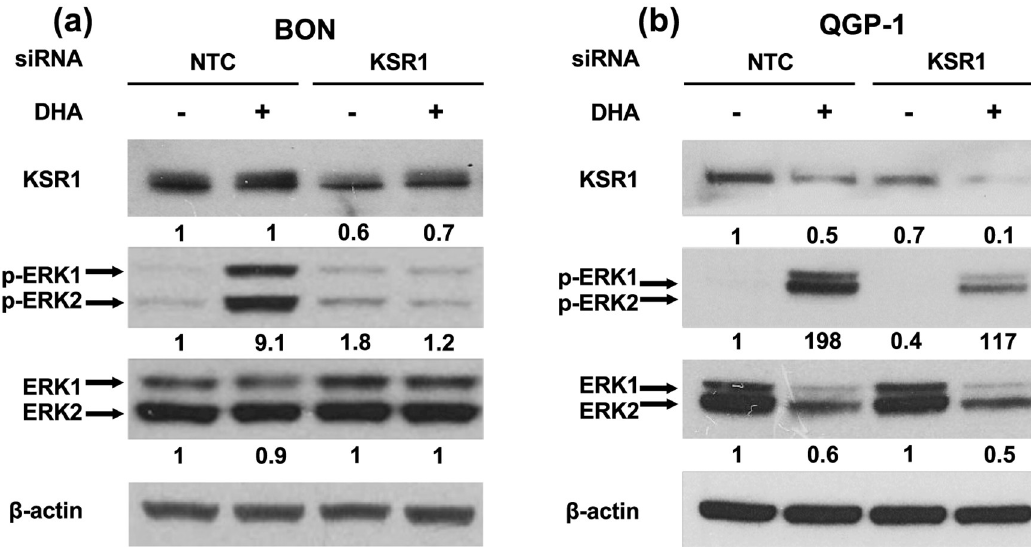
Fig 3. Knockdown of KSR1 attenuates ERK1/2 signaling. (a) BON and (b) QGP-1 cells were transfected with KSR1-targeting siRNA and treated with or without 100 μ M DHA for 90 min. Cells were lysed and western blotting analysis performed. Band intensity is indicated below the corresponding band and expressed as fold-change relative to NTC. Each blot is representative of three independent experiments.